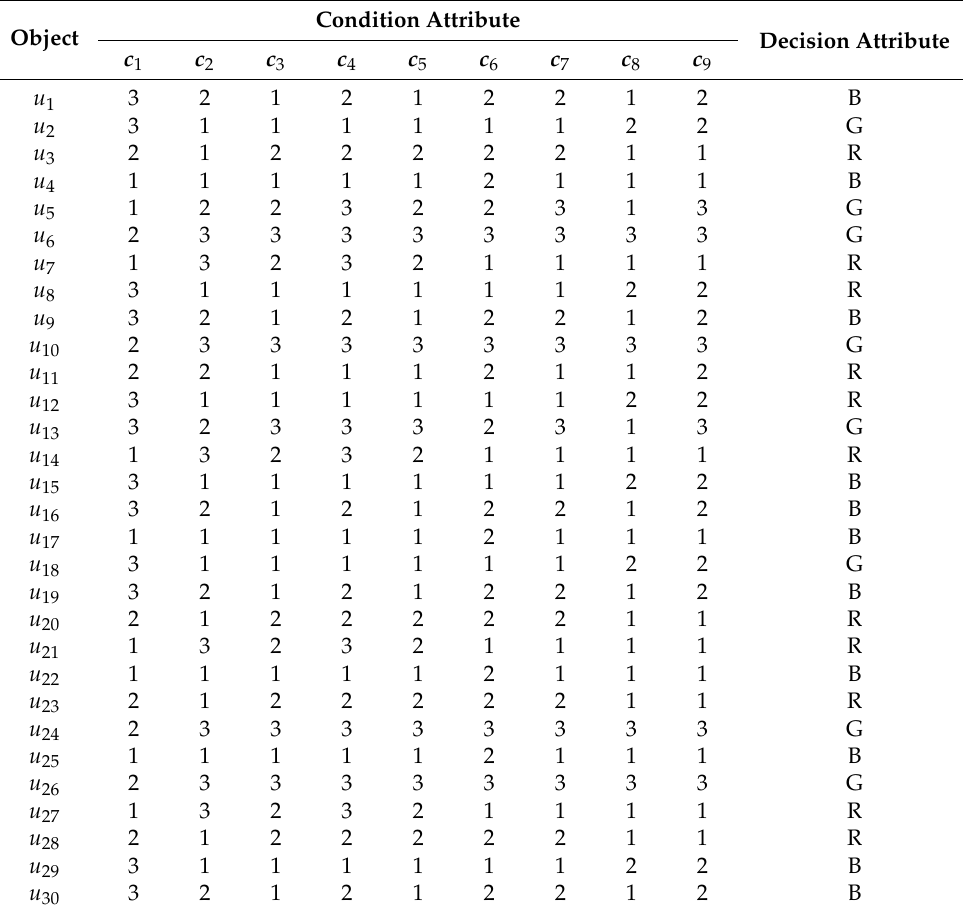
Table 2. Customer selection decision